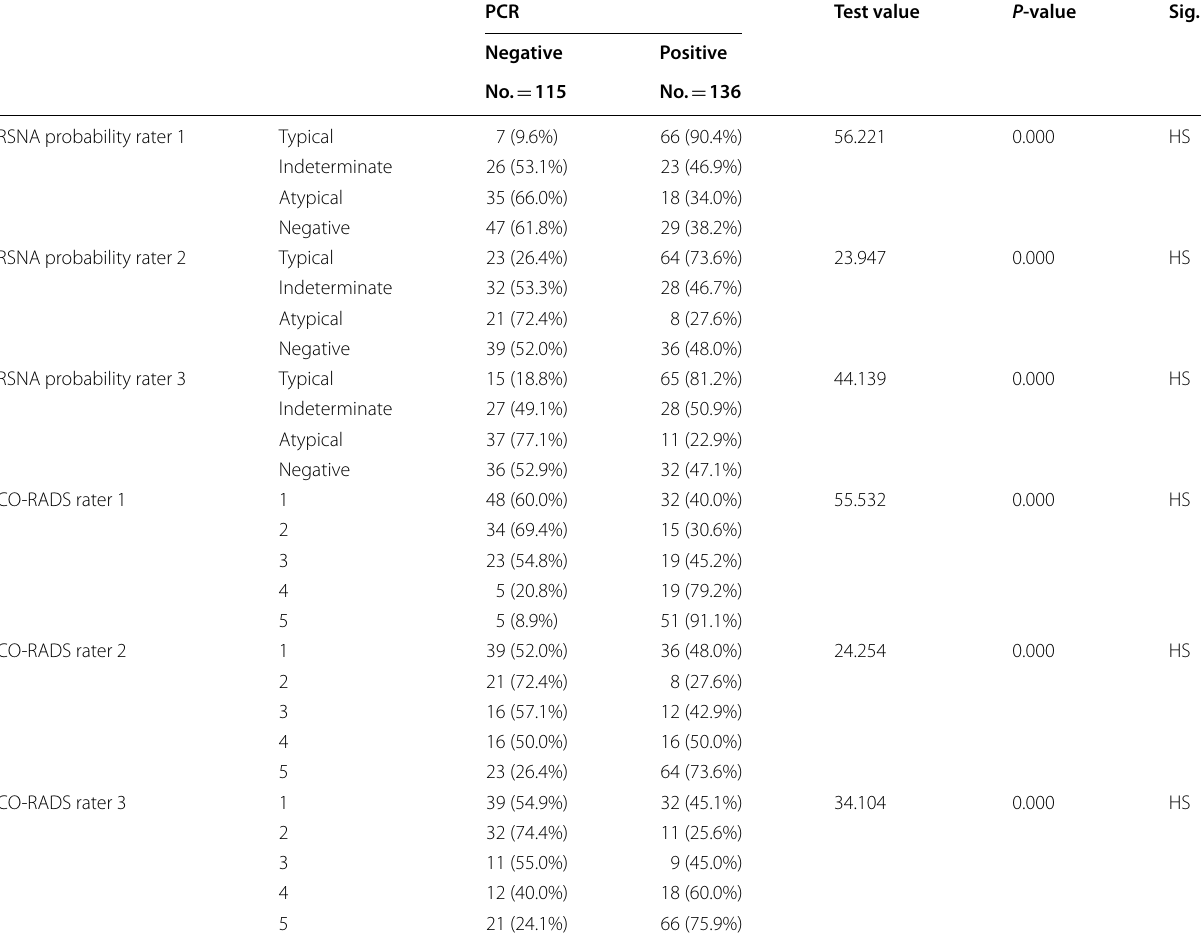
Data are expressed in number and percentage. The probability of error ( P -value) at 0.05 was considered significant ( S ), 0.01 and 0.001 are highly significant (HS), while > 0.05 are considered non-significant